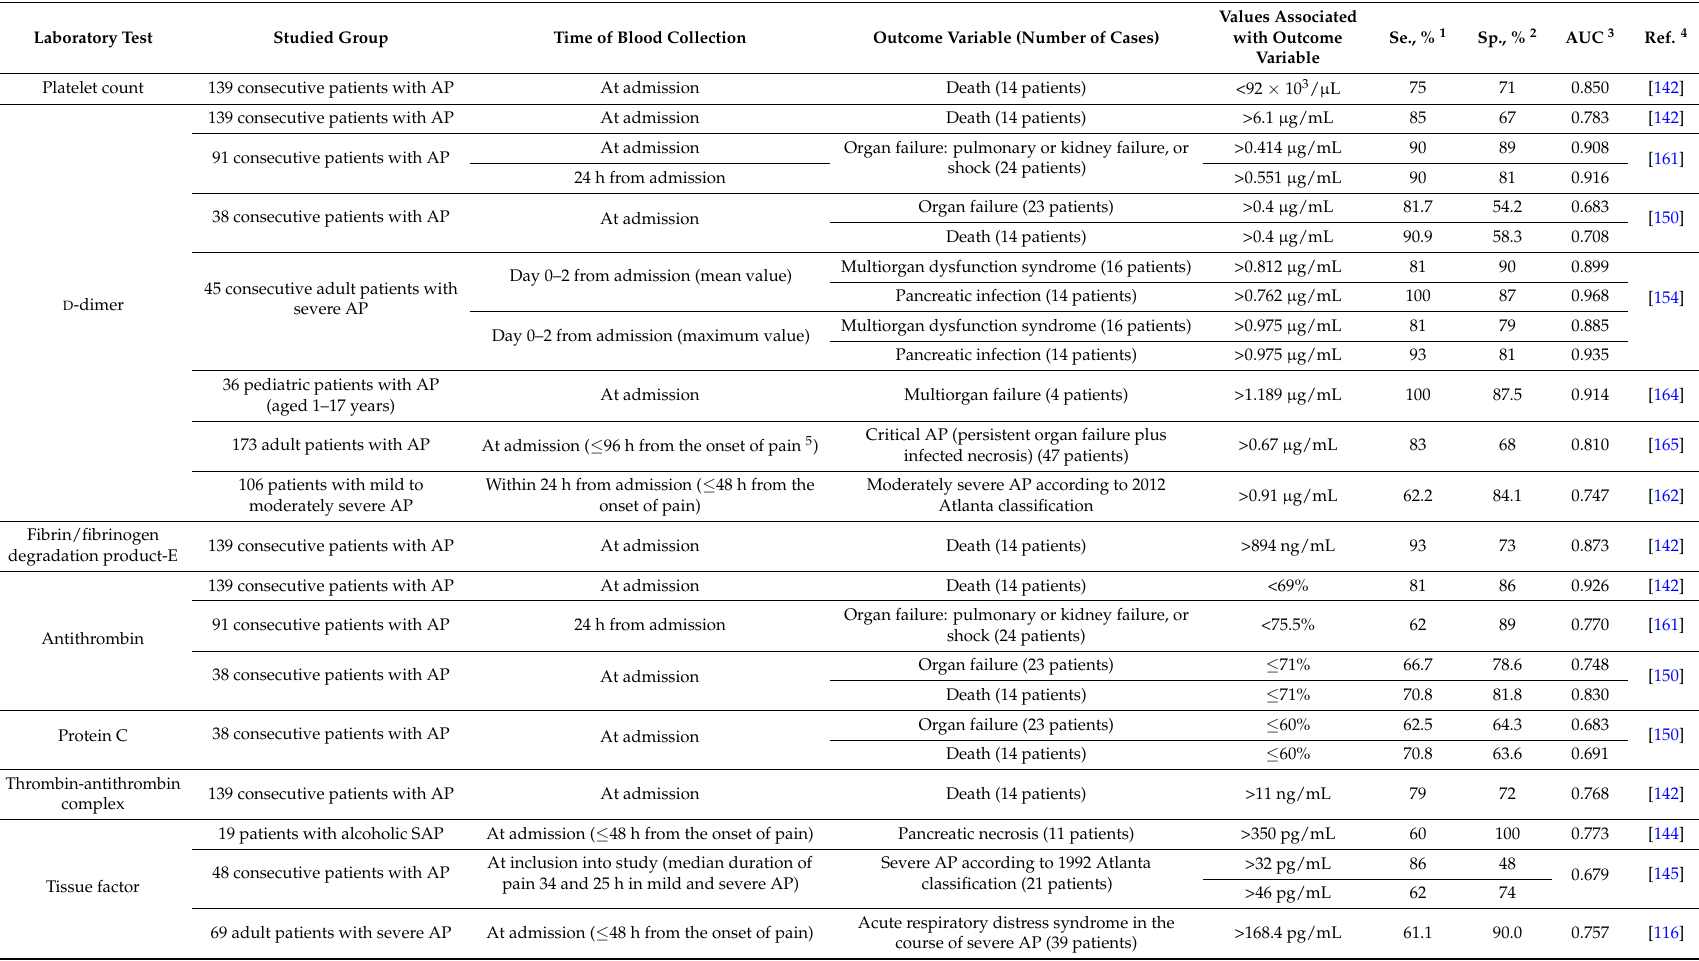
Table 2. Diagnostic accuracy of laboratory markers of hemostasis measured in whole blood (platelet count) or plasma (other markers) for the prediction of severity, complications and mortality of acute pancreatitis